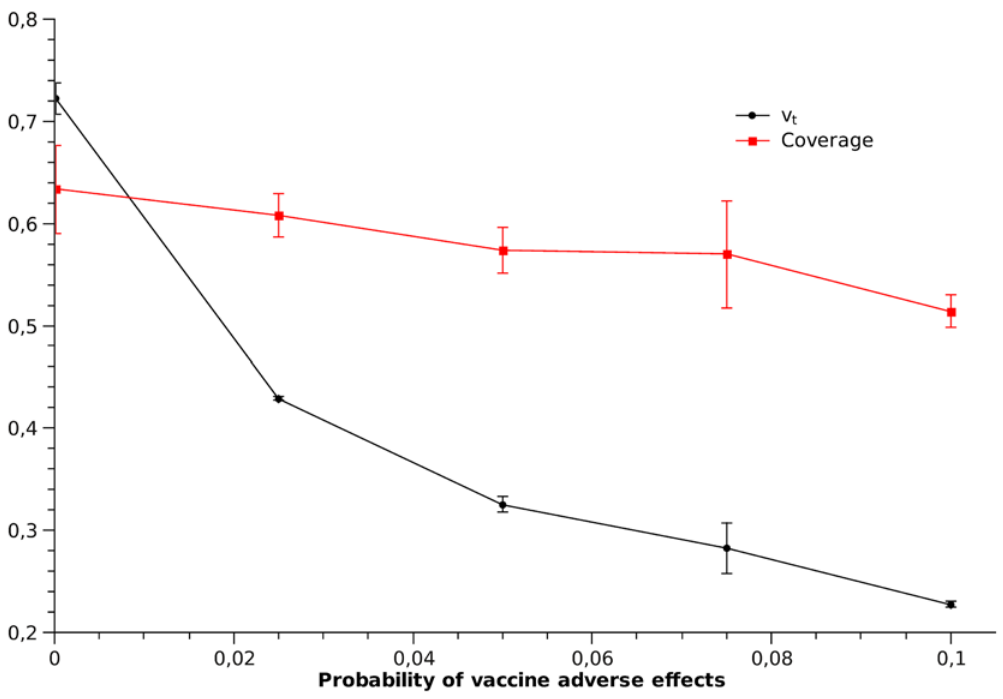
Figure 5. Vaccine coverage and willingness to vaccinate for vaccines with different levels of safety. Coverage and v t values are averages and standard deviations over the population values in the last week of simulation.